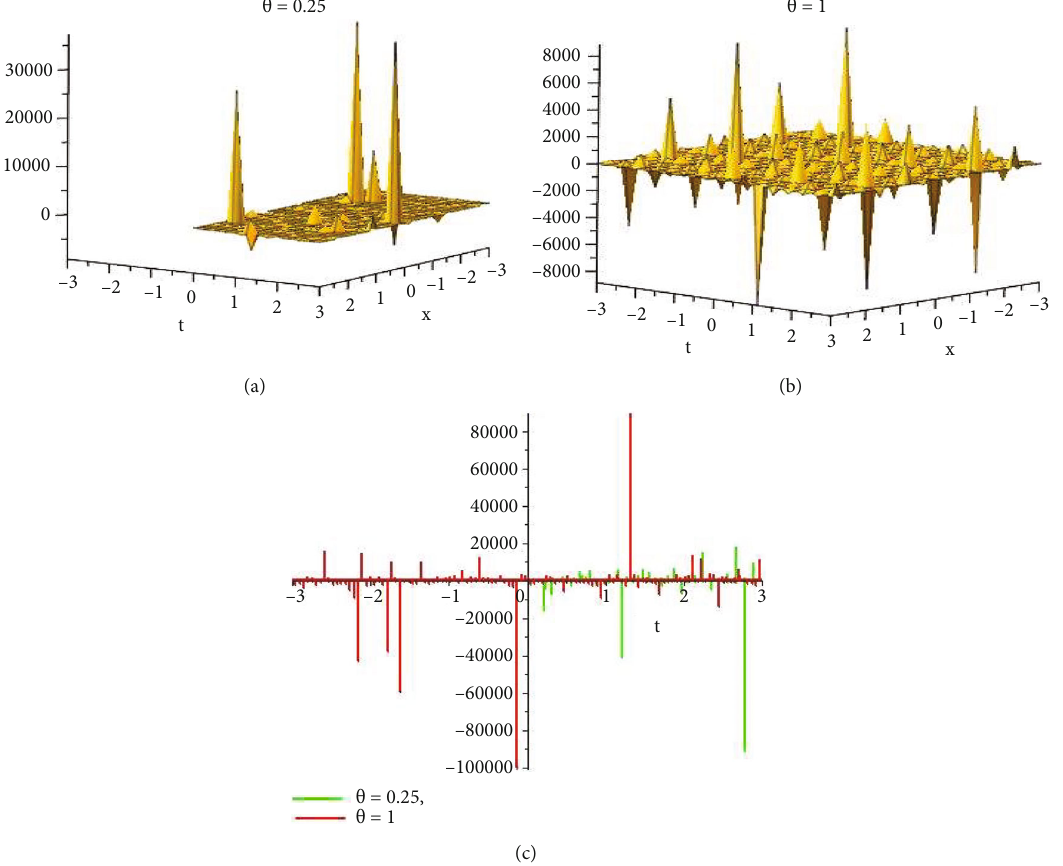
, y , t Þ . (a, b) 3D plot and (c) 2D combined plot for x = 1 3 ð x